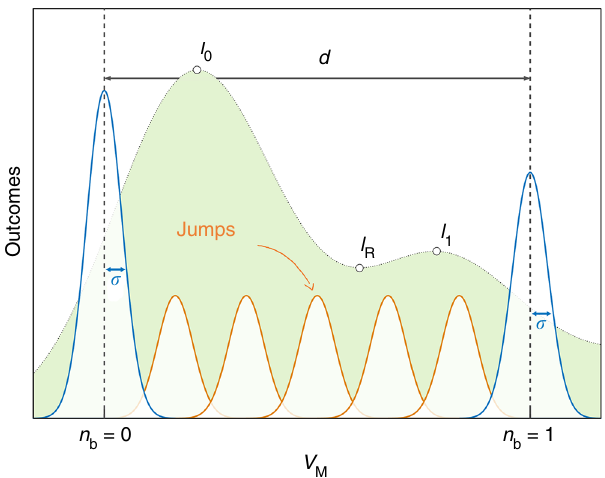
of the outgoing signal ^ V , e out